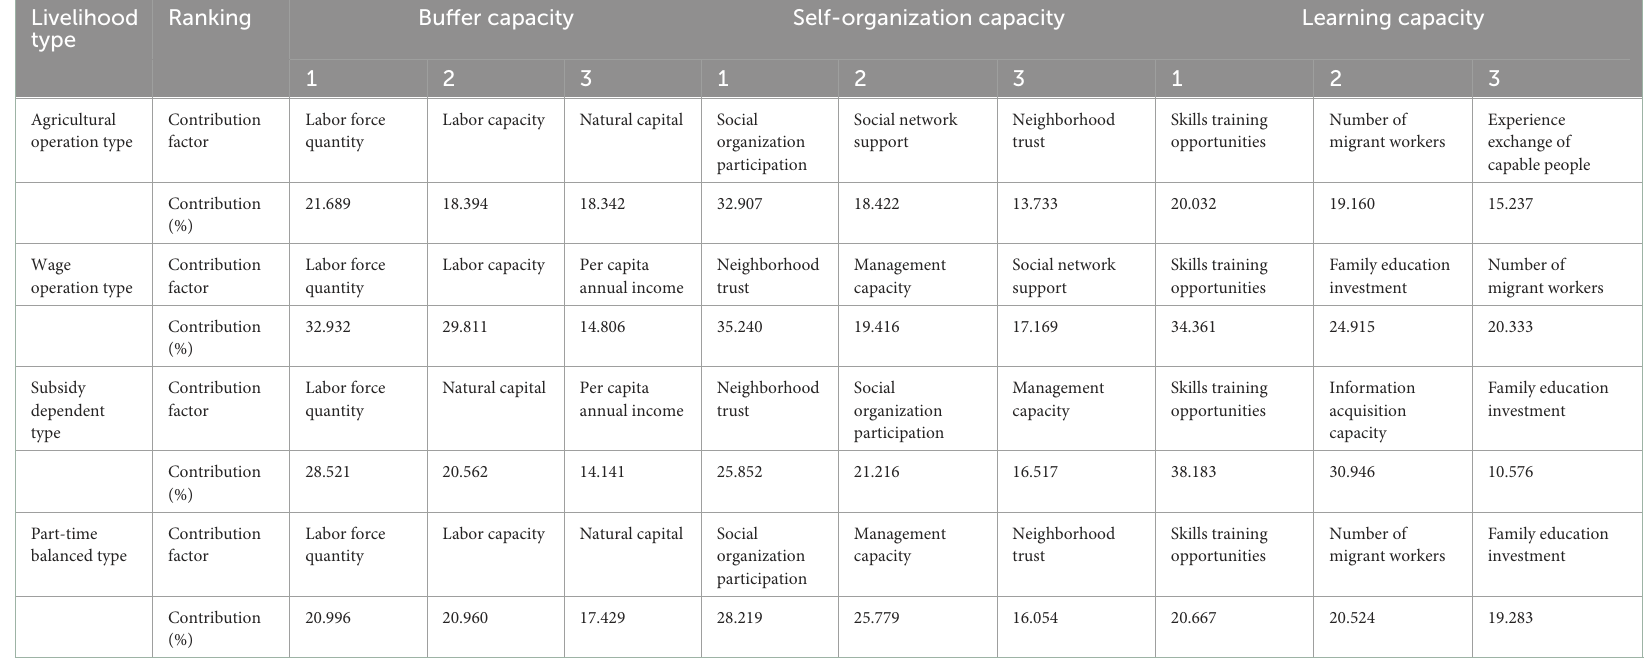
TABLE 6 Main contributing factors to the livelihood resilience of resettled